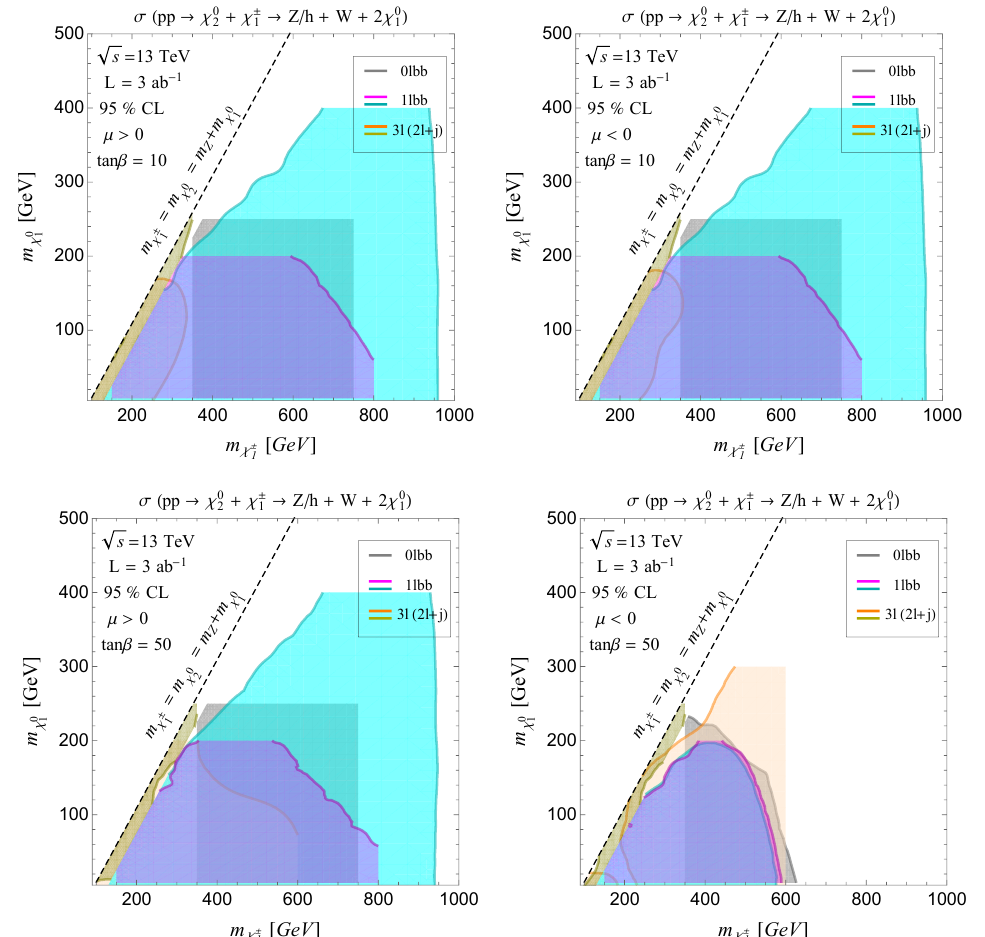
Figure 10 . Constraints on the Bino-Wino scenario projected at 3 ab − 1 at 95% confidence level with M SUSY = | µ | = 10 TeV. The labels are similar to figure